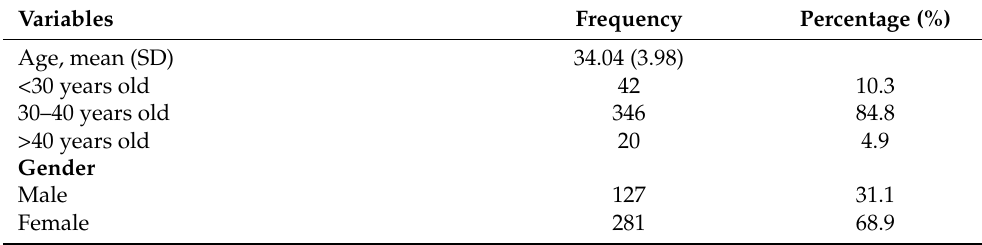
Table 1. Distribution of respondents’ socio-demographic, socio-economic, and cultural